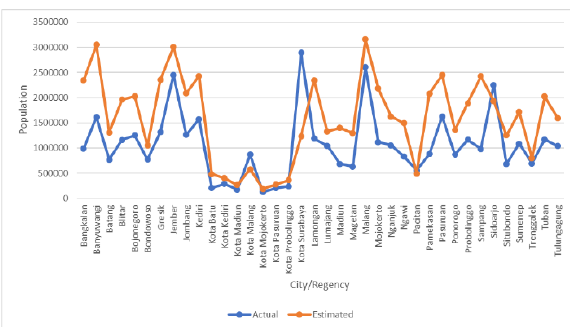
Figure 4 . Comparison of estimated population to actual population in Jawa Tengah Province in 2019 by city/regency.